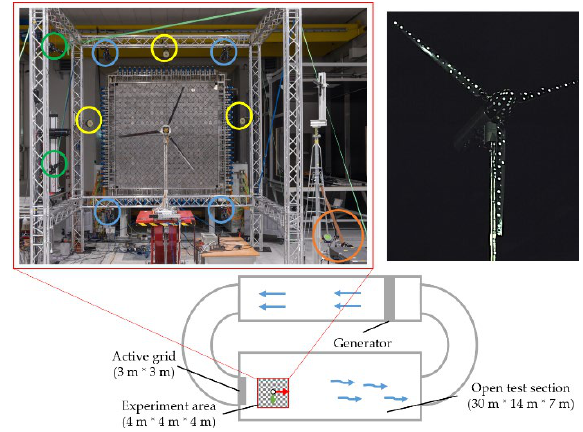
Figure 3 . Measurement setup in the wind tunnel with the active grid in the background. The green and red arrow define the global coordinate system. The blue arrows show the wind flow direction. On the right side, the MoWiTO with measurement targets.